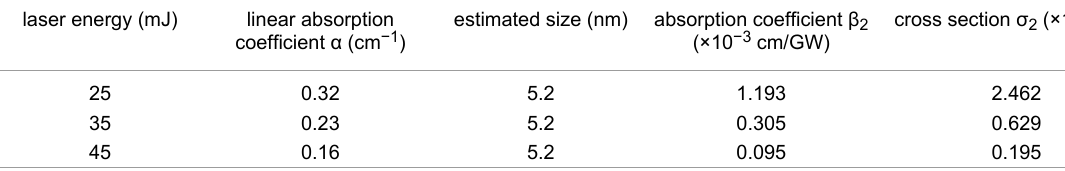
Table 3: Fitted nonlinear optical parameter of Ag 2 S QDs for closed-aperture Z -scans. a